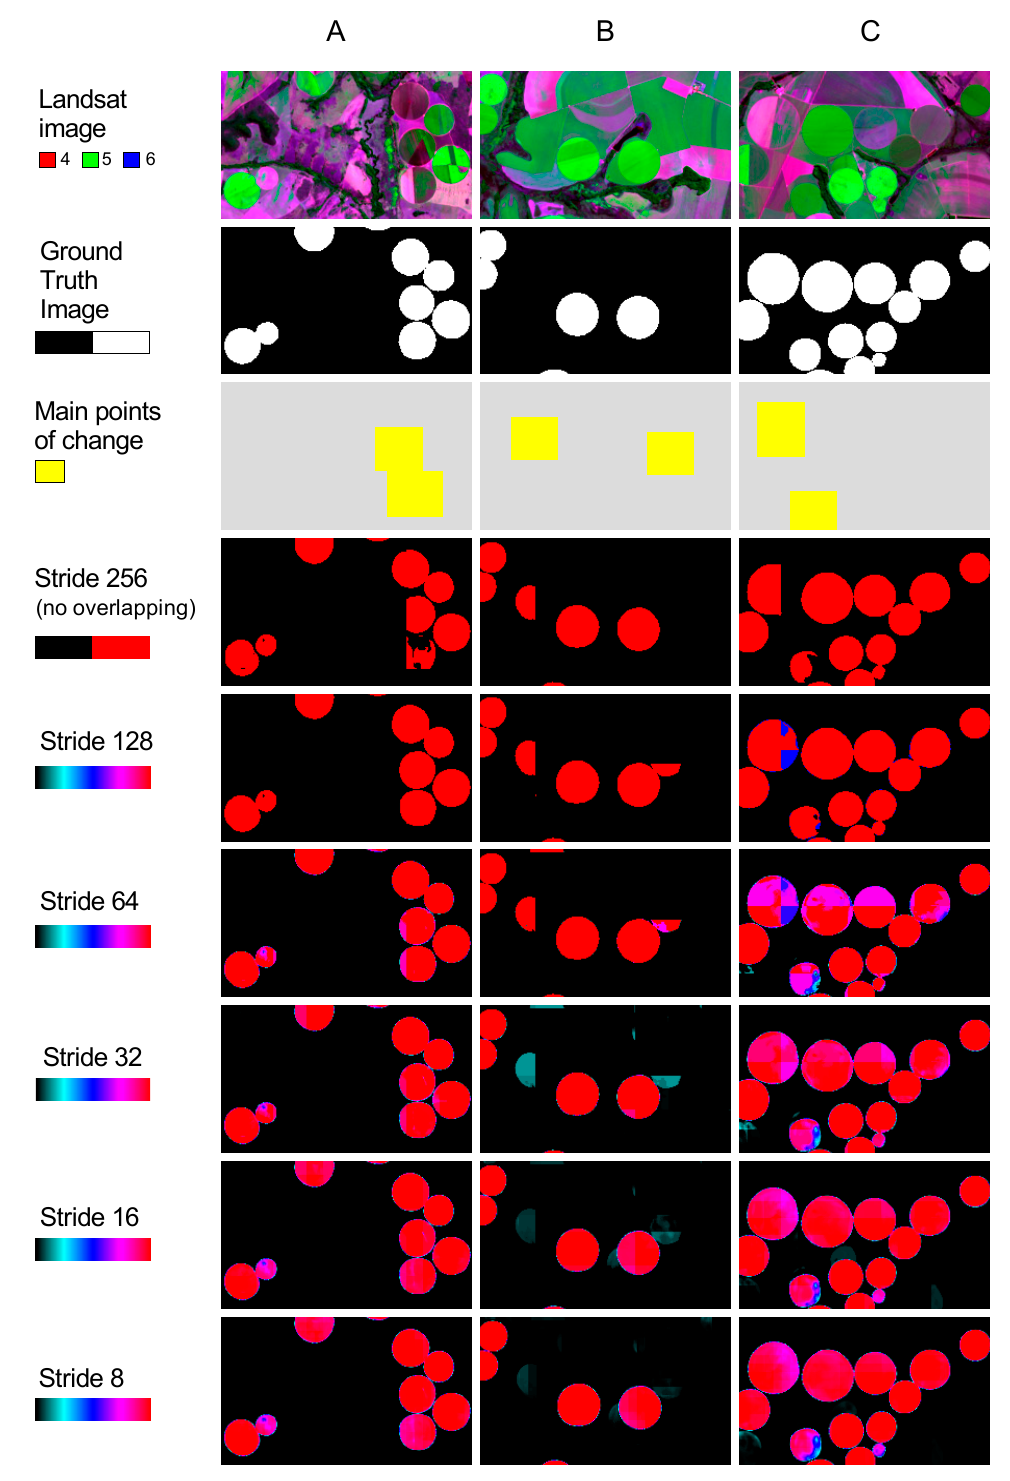
Figure 8. Minimization of errors by increasing the sliding window overlap. Three examples of sub-images ( A – C ) represented by the following images: Landsat image, ground truth, the positions of the changes between the reconstructed images, and the result of the image reconstruction with stride values of 256, 128, 64, 32, 16 and